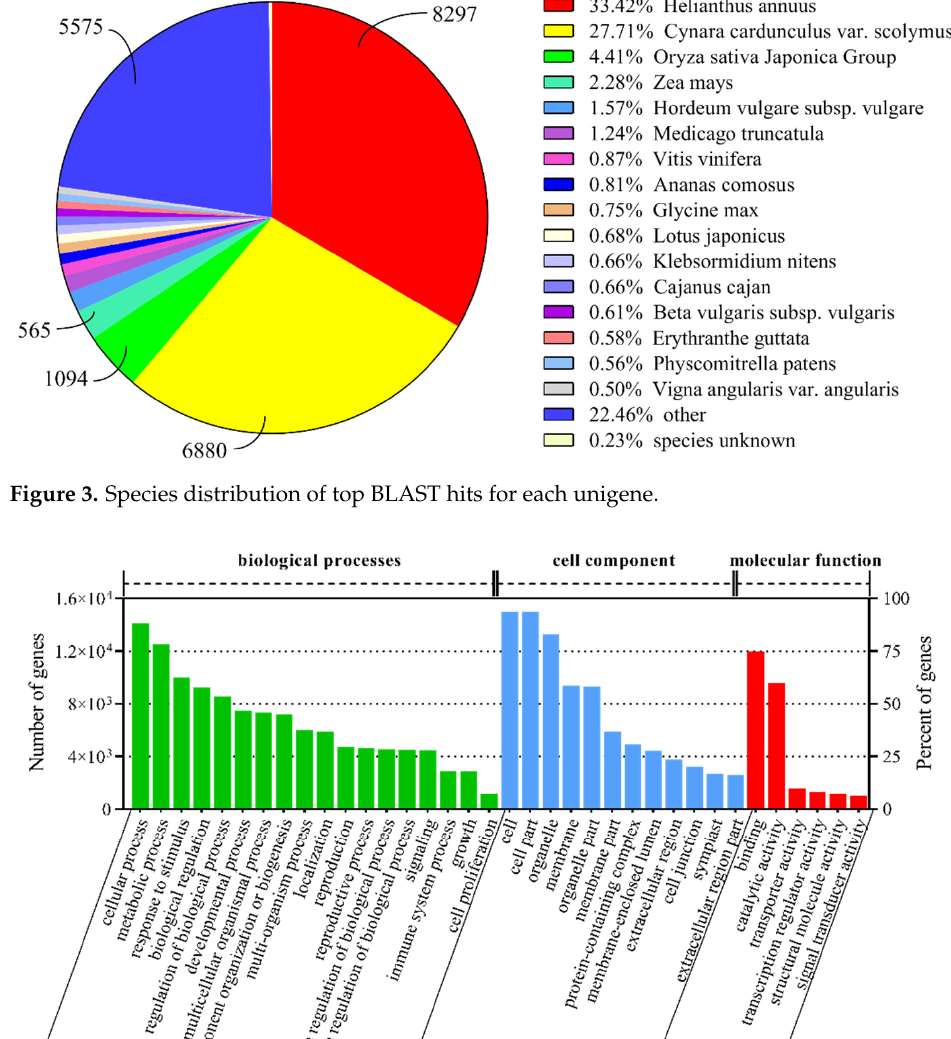
Figure 3. Species distribution of top BLAST hits for each unigene.